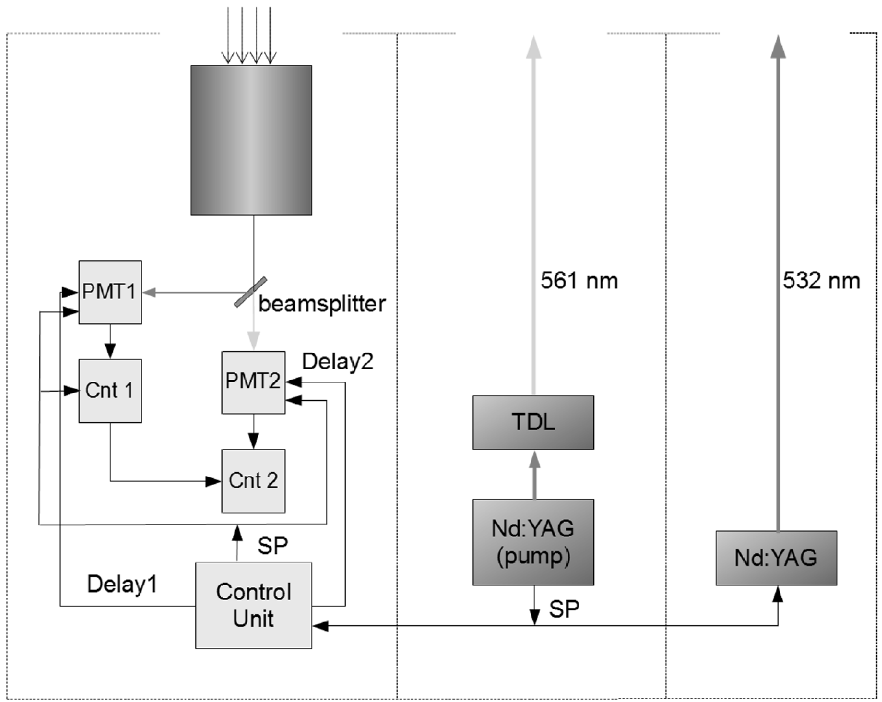
Figure 3. Optical block diagram of the lidar system. Here, TDL is the dye laser, NdYAG is the solid-state laser (532 nm), SP is the synchronizing pulse, Cnt 1 and 2 are photon counters, PMT indicates the photomultiplier tube, and CU is the control unit.